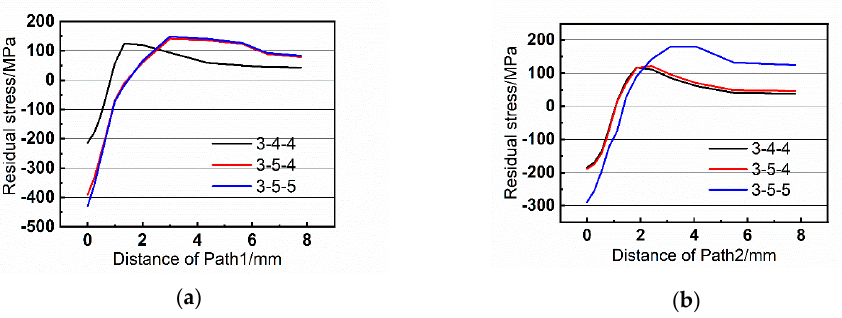
Figure 15. Residual stress of the paths with strap thickness of 3 mm. ( a ) Path1 and ( b ) Path2. The residual stress distributions of the riveted butt joints under tensile load are illustrated in Figure 16. The second kind of bending effect can be seen clearly in the diagrams. The bending will cause additional bending distance when the joint is subjected to the tensile load, which will shorten the fatigue life of the riveted joint. When the thickness of the strap increases, the second bending effect of the joint will be weakened so the fatigue performance will be improved.